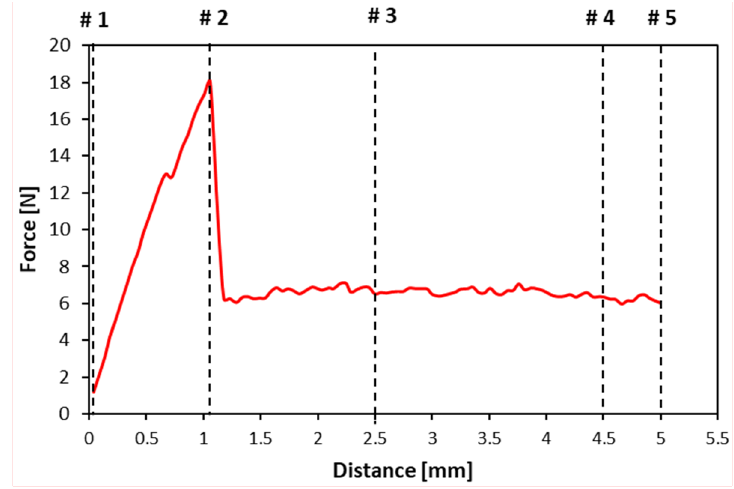
Figure 2. Example of force–distance curve obtained from CT3 Brookfield Texture Analyzer with results from a compression test of an unpeeled half apple sample. The computed textural parameters are described in Table 1, using the anchor numbers located on the upper edge of the curve. Table 1. Parameter definition and calculation for texture